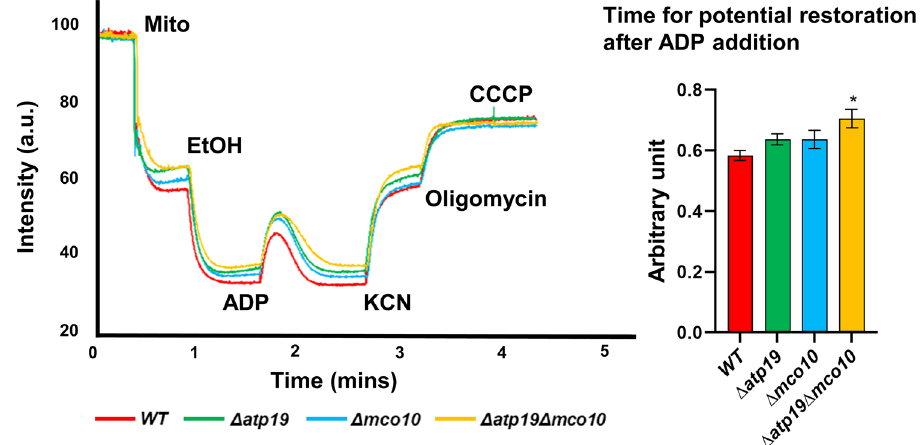
Figure 4. Variations in the mitochondrial inner membrane potential in isolated mitochondria from strains grown at 28 °C measured under osmotic protection. The additions were 0.5 μg/mL Rhodamine 123, 150 μg/mL of mitochondrial proteins (Mito), 10 μL ethanol (EtOH), 75 μM ADP, 2 mM potassium cyanide (KCN), 4 μg/mL oligomycin (oligo), and 4 μM carbonyl cyanide-m-chlorophenyl hydrazone (CCCP). Traces are representative of three independent experiments, and the histogram refers to the time that is needed for restoration of ΔΨ after ADP addition. Statistical significance of differences versus control mitochondria is indicated by * p ≤